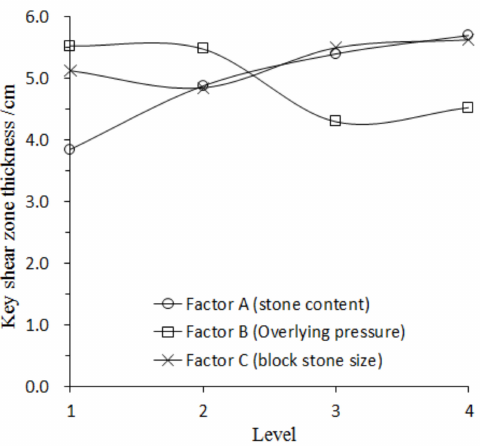
Figure 14. Relationship between the key shear zone thickness and the levels of di ff erent